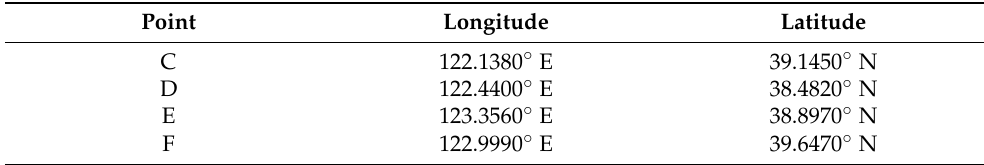
Table 2. Coordinates of points in the range of the calculation domain.